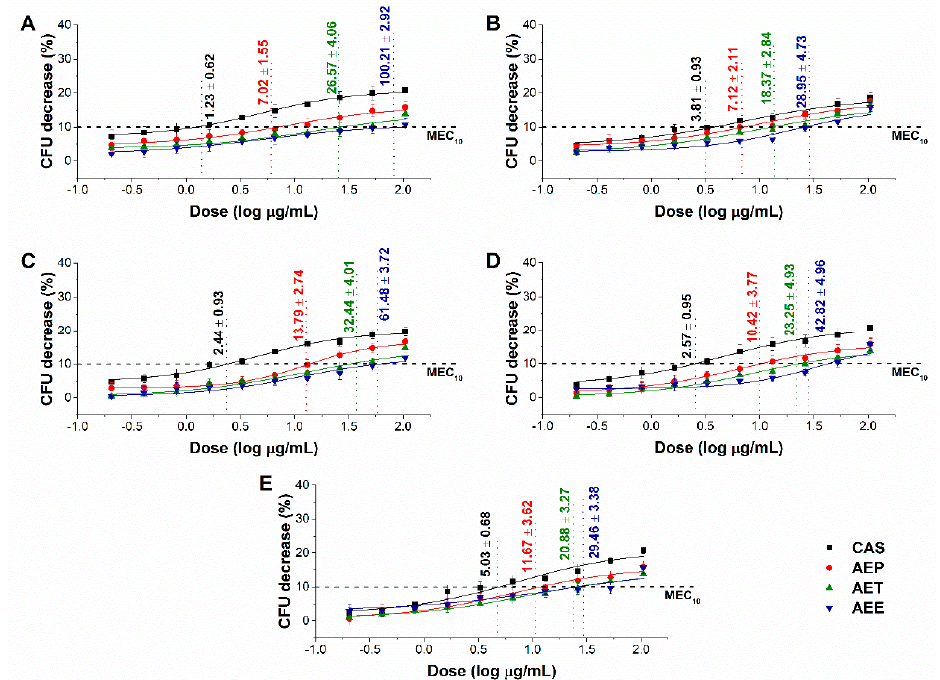
Figure 6. Minimum effective concentration (MEC 10 ) of AEP, AET, and AEE (µg/mL) on S. pombe ( A ), C. albicans ( B ), C. tropicalis ( C ), C. dubliniensis ( D ) and C. krusei ( E ). Six independent experiments, each